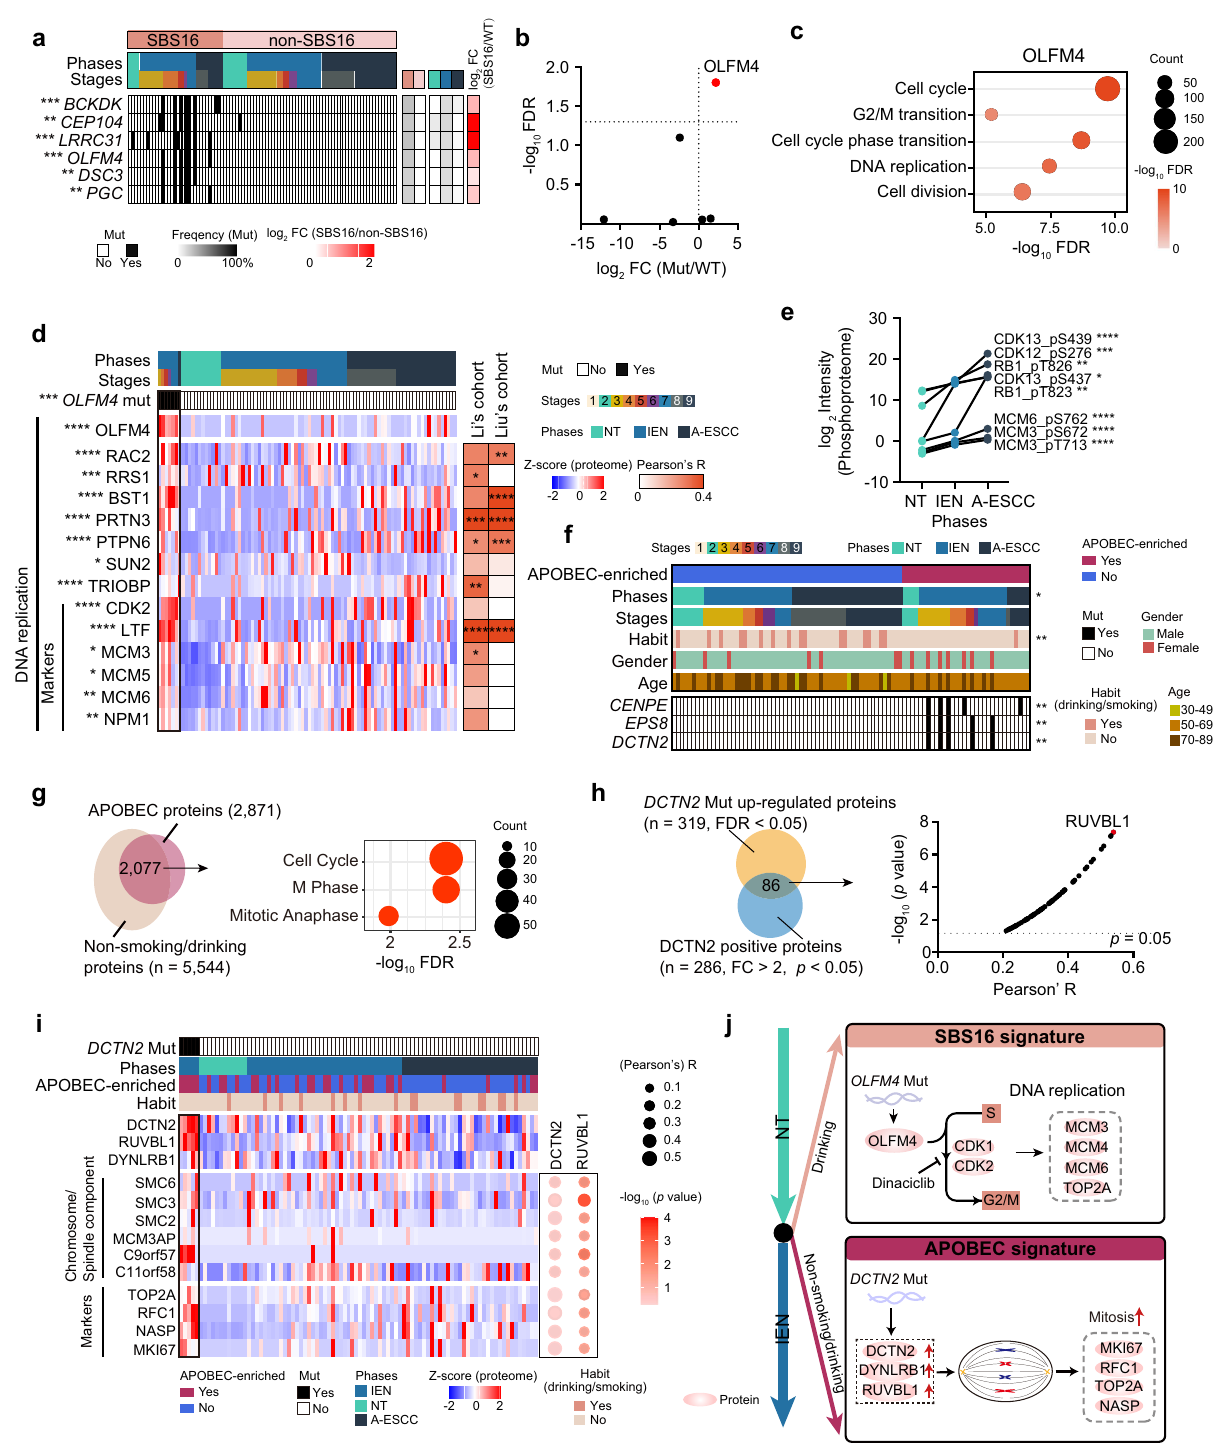
perturbation pro fi les had signi fi cantly positive cis effects on their associated proteins (Fig. 3b). Interestingly, nearly 35% genes at chr3q gain were positively associated with Ca 2+